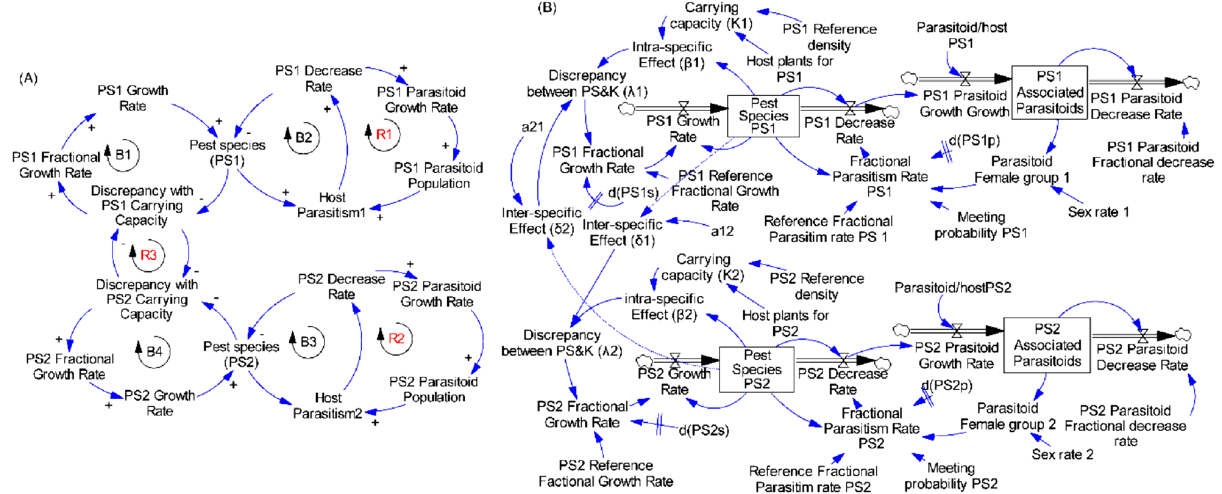
Figure 5. Causal loops ( A ) and flow diagram ( B ) of two pest species and its parasitoids and the resource in the system.